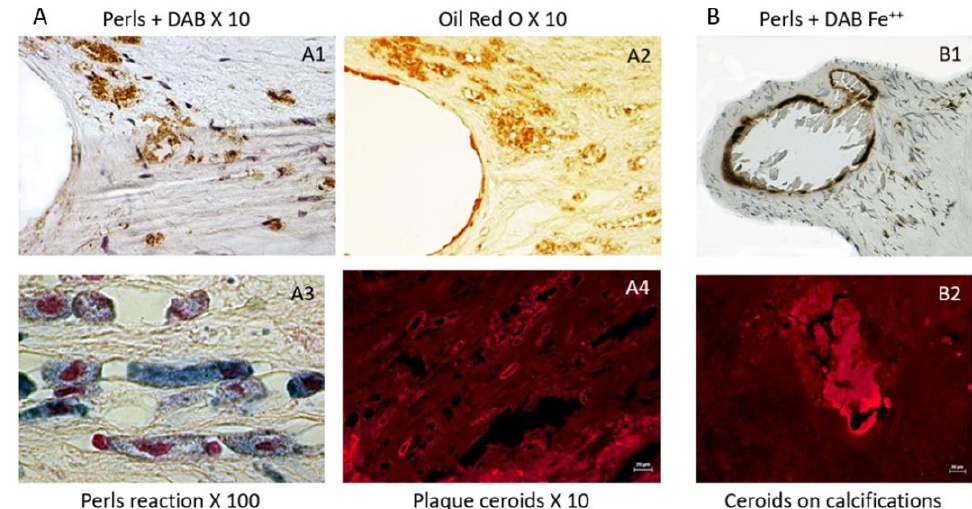
Figure 2. Histological views of tissue hemolysis in human aortic plaques and valves: ( A ) atherosclerosis (( A1 ) Perl’s + DAB staining of redox-active Fe ++ in the shoulder of an atherosclerotic plaque; ( A2 ) ORO lipid staining, colocalizing with Fe ++ on a serial section; ( A3 ) high magnification of foam SMCs by Prussian blue precipitation, showing the presence of Fe +++ , potentially linked to ferritin (redox-inactive); and ( A4 ) autofluorescent (550-nm wavelength, red) ceroid rings in an atherosclerotic plaque); and ( B ) calcified aortic valves (( B1 ) a crown of ferrous iron around calcification in an aortic valve, suggesting a compliant mismatch between the solid calcification and the soft elastic valve tissue; and ( B2 ) red autofluorescence (550-nm wavelength) directly associated with aortic valve calcification). Int. J. Mol. Sci. 2020 , 21 , x FOR PEER REVIEW